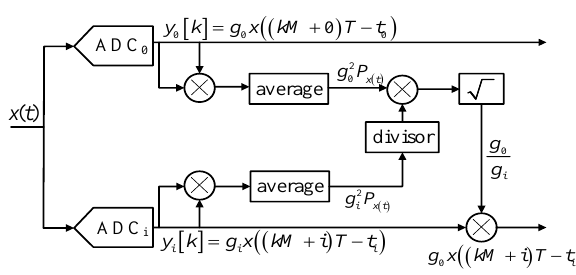
Figure 3. Gain mismatch calibration for each sub-ADC.